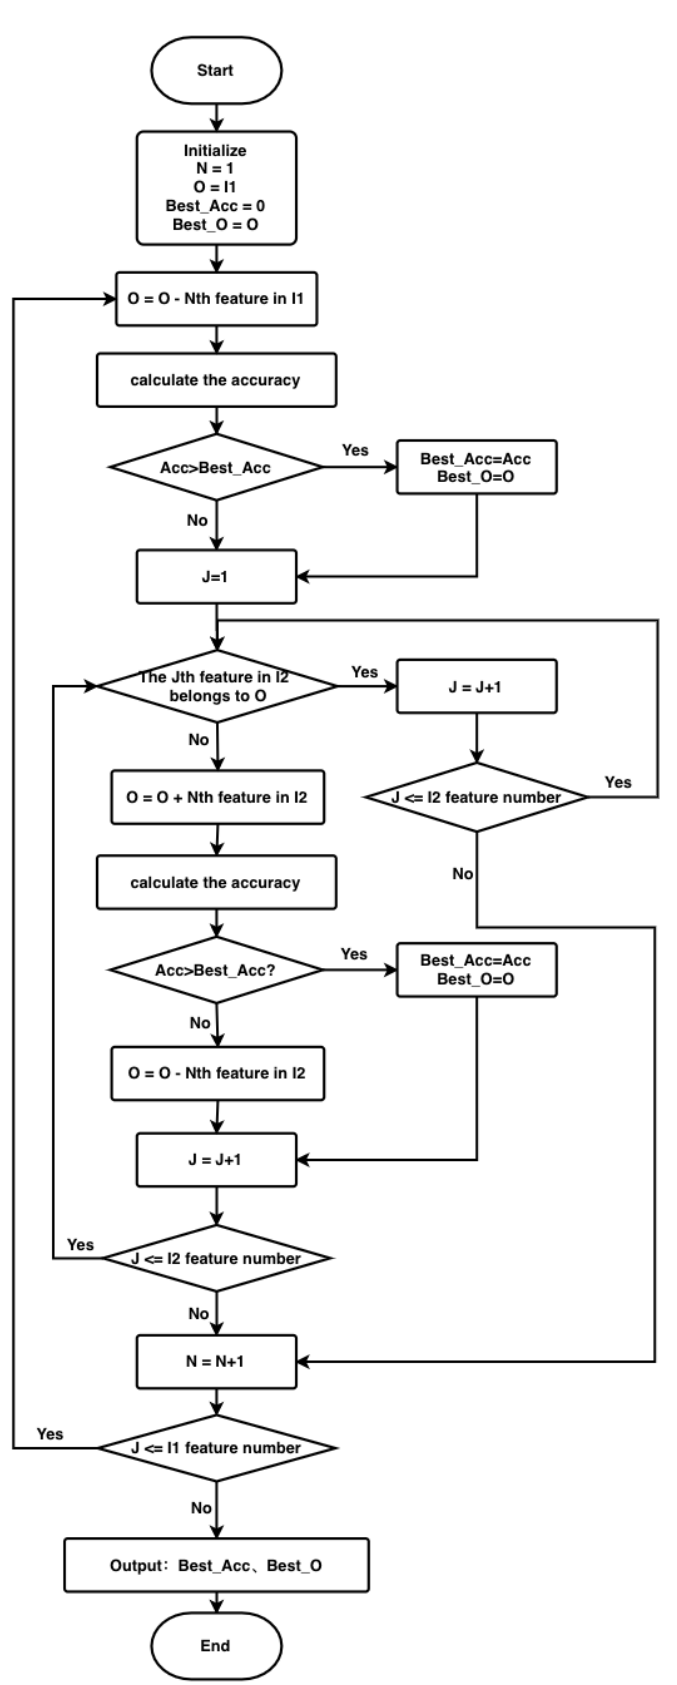
Figure 2. The flowchart of the XGBIBS algorithm (the BFGSBS